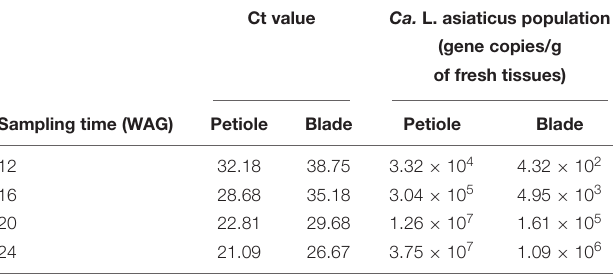
TABLE 1 | Detection and quantification of Ca. L. asiaticus genomes by quantitative polymerase chain reaction (qPCR) in petiole and blade tissues of HLB-infected citrus